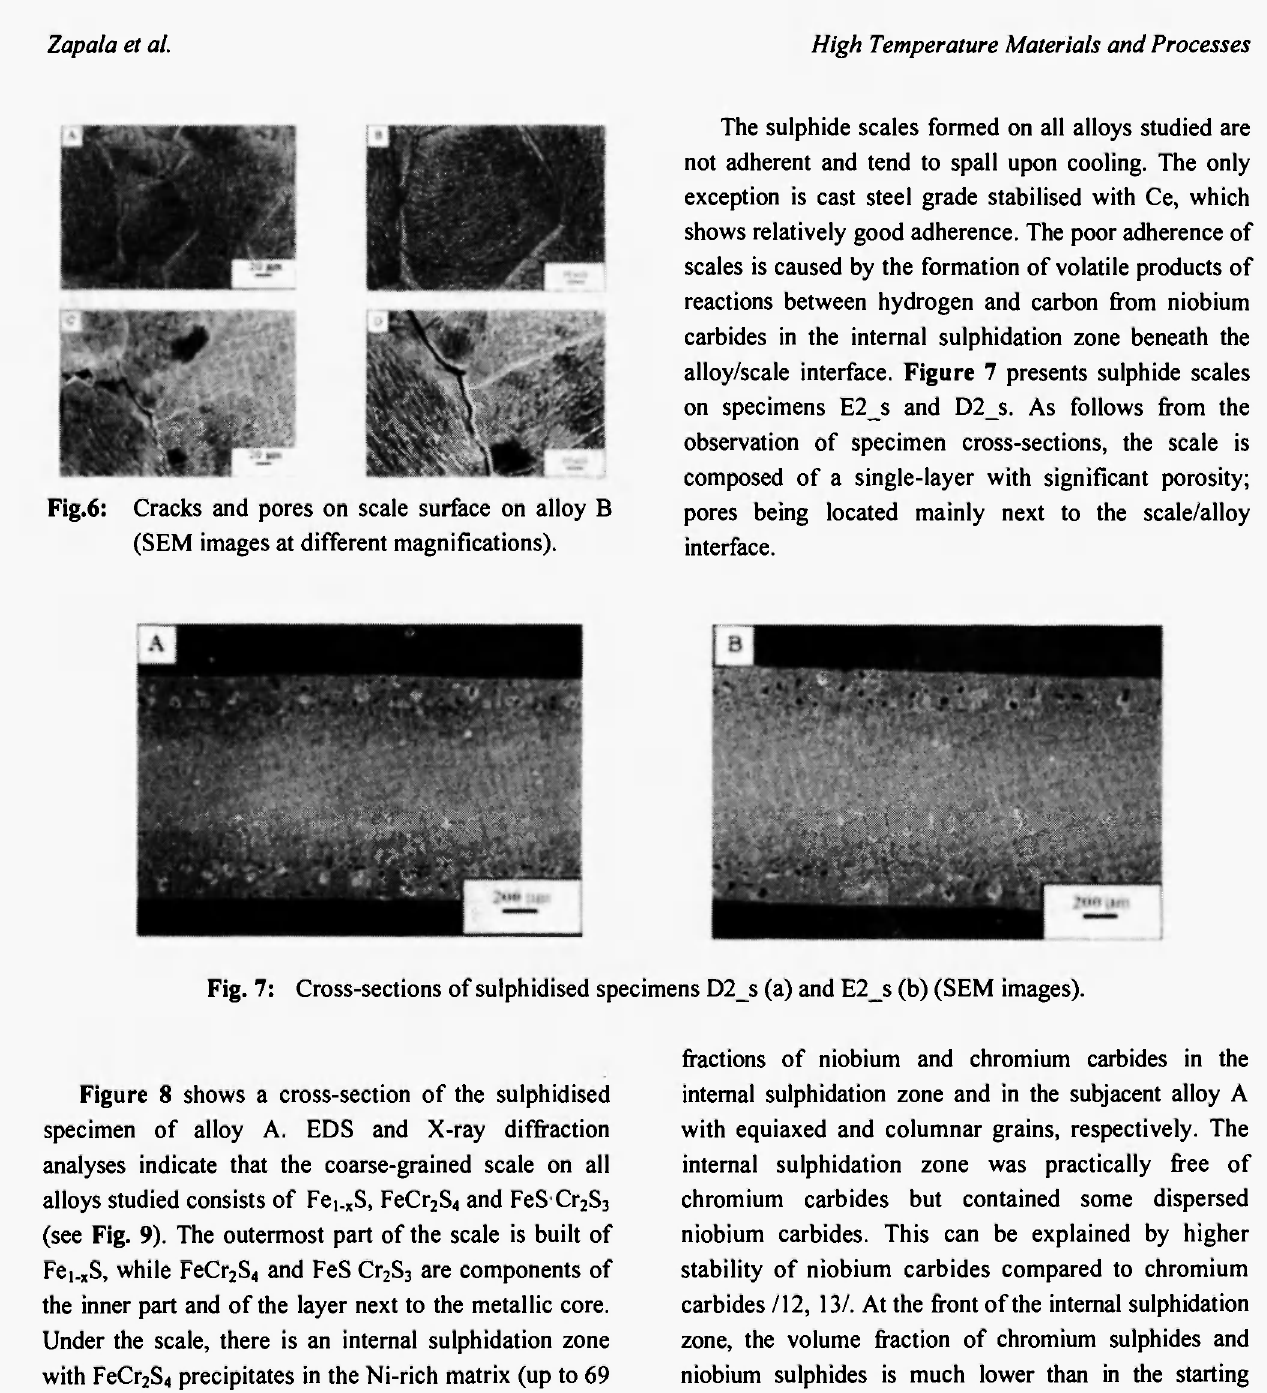
Fig. 7: Cross-sections of sulphidised specimens D2_s (a) and E2_s (b) (SEM